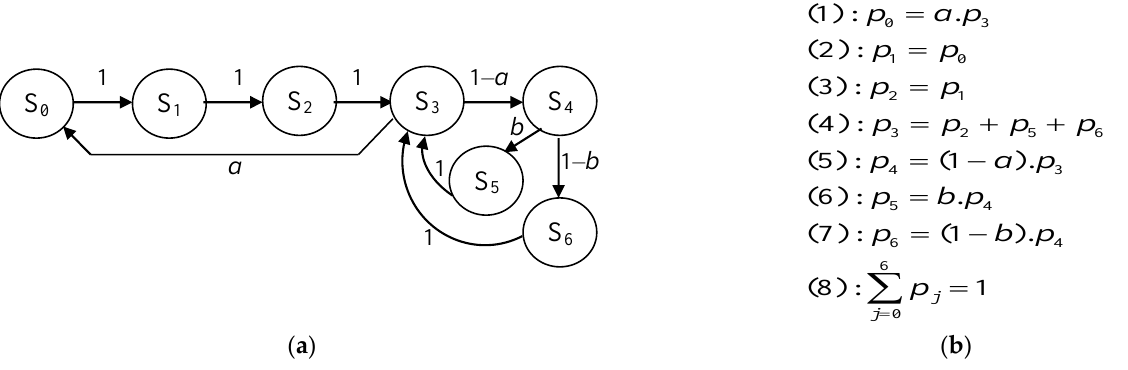
Figure 6. Definition of the model as a SPN. ( a ) Graph of the states of the Markov